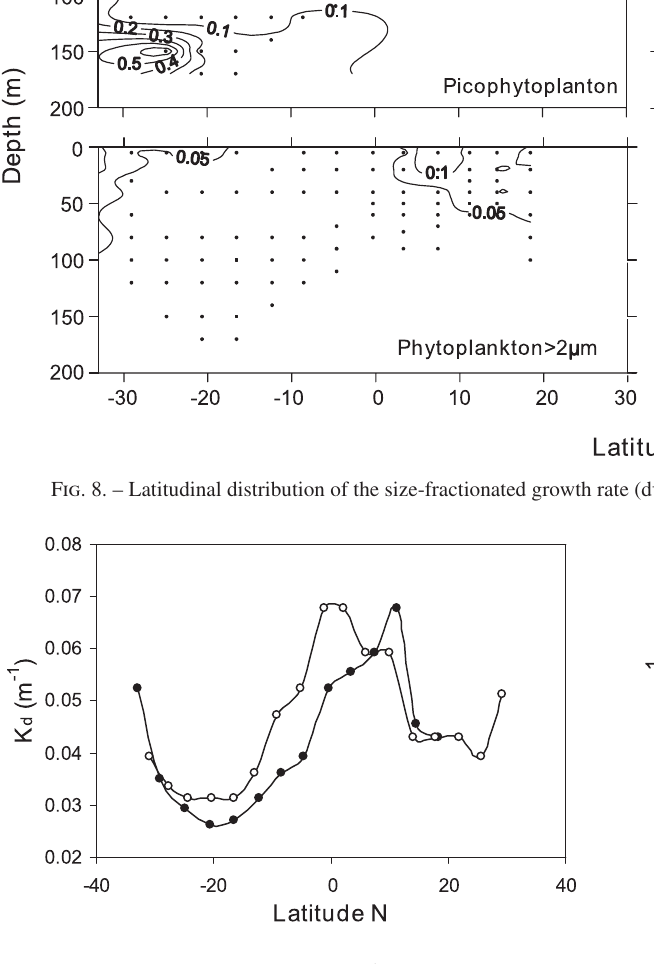
Fig . 9. – Latitudinal distribution of K (m -1 ). Black circles, Tryni- d trop 2007; White circles, Trynitrop 2008